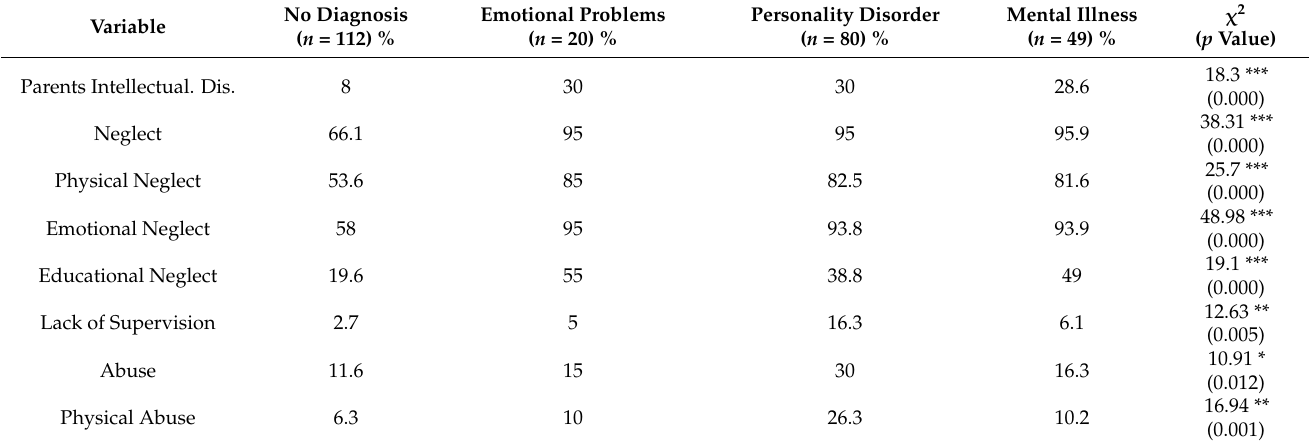
Table 2. Associations between Parents’ Mental Health Diagnoses and Child